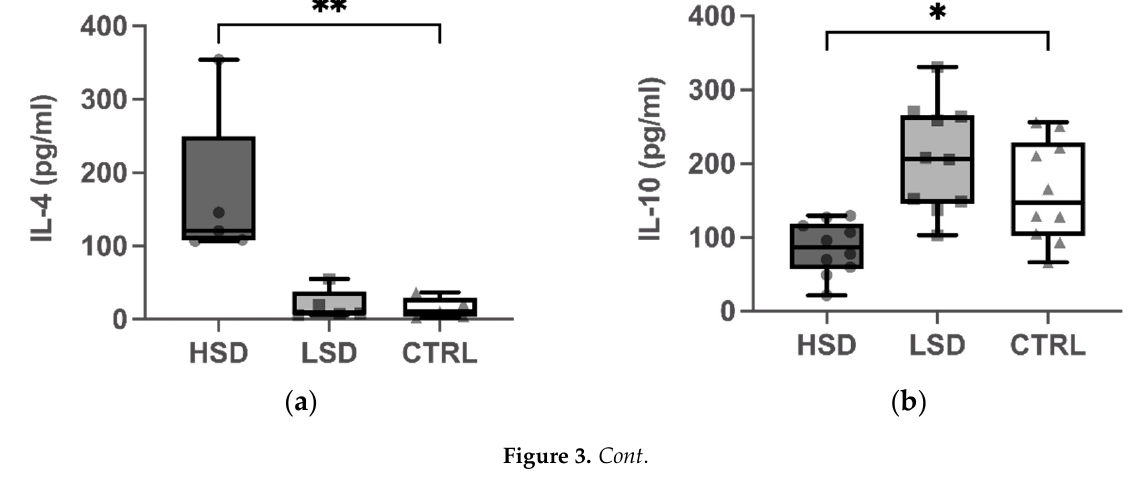
( c ) Figure 3. Effect of different concentrations of dietary sodium on the production of cytokines by splenocytes. Splenocytes were isolated from the spleens after OVA challenge and incubated in culture medium containing fetal bovine serum (FBS) and OVA for 1 to 3 days. Interleukin (IL)-4 ( a ), IL-10 ( b ), and interferon- 𝛾 (IFN- 𝛾) ( c ) were measured by sandwich ELISA. Data are expressed as box-and-whisker plots with individual data points. The boxes represent the inner quartiles value range with the median indicated as black line. The whiskers represent minimum to maximum interval. * p < 0.05 and ** p < 0.01. High-salt diet: HSD, Low-salt diet: LSD, Control diet: CTRL 3.3. HSD Causes No Change in the Serum Levels of Sodium and Chloride To determine the effect of the different salt concentrations on electrolyte homeostasis, plasma concentrations of sodium (Na) and chloride (Cl) were evaluated after the administration of a special salt diet for 10 weeks (Figure 4). Dietary salt had no effect on plasma levels of Na and Cl for all mice from the three groups. ( a ) ( b ) Figure 4. Effect of different concentrations of dietary sodium on the levels of serum sodium (Na; ( a )) and chloride (Cl; ( b )). Mice were fed a high- or low-salt diet, or a control diet ad libitum for 10 weeks. Blood samples were collected 1 day after administering the specialized diet. Data are expressed as box-and-whisker plots with individual data points. The boxes represent the inner quartiles value range with the median indicated as black line. The whiskers represent minimum to maximum interval. High-salt diet: HSD, Low salt diet: LSD, Control diet: CTRL.